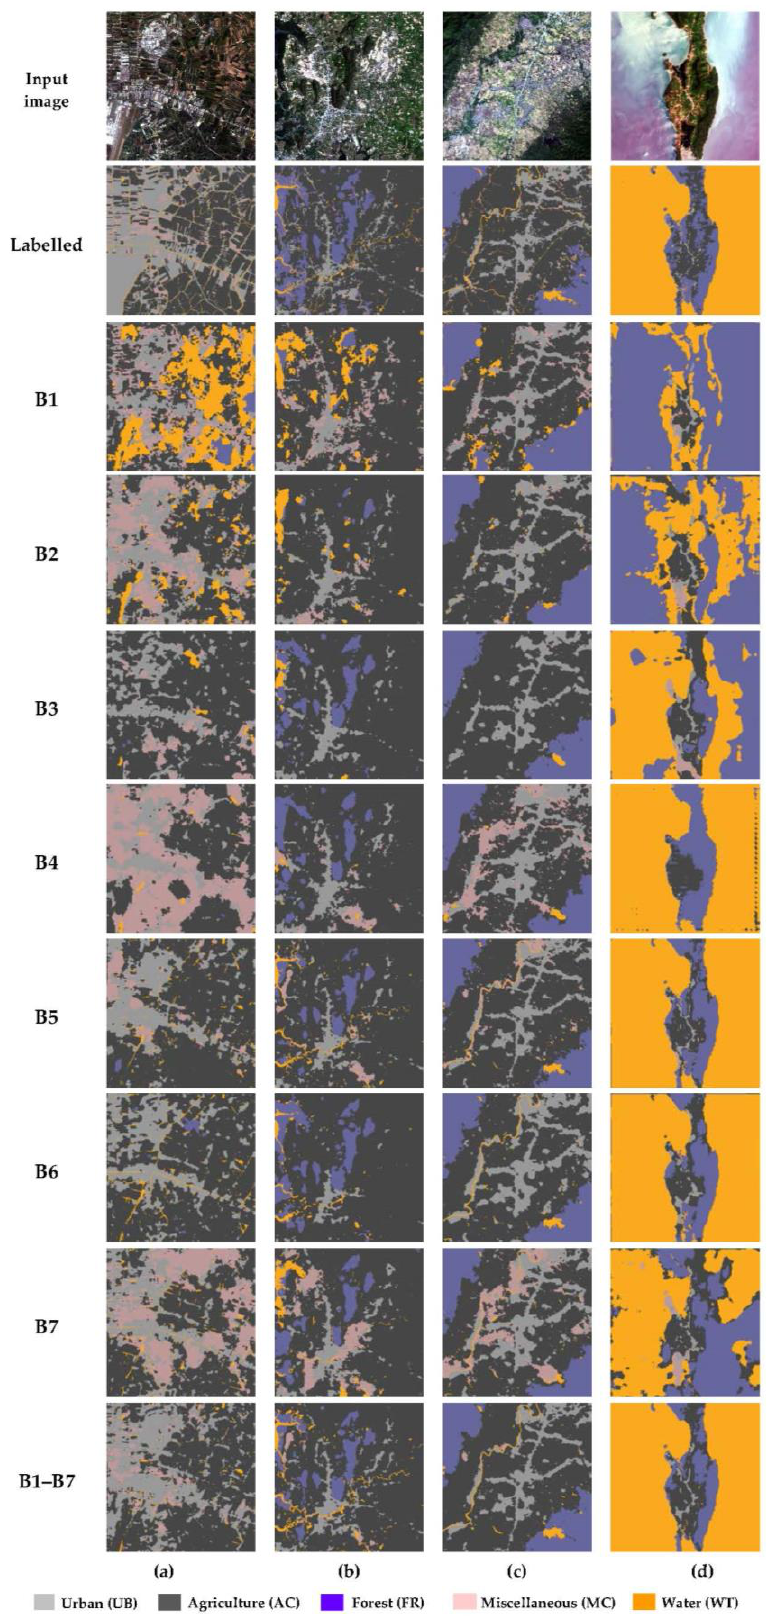
Figure 8. The segmentation results of spectral bands on the land use dataset. ( a ) urban and agriculture area; ( b ) urban, agriculture, and forest areas in countryside; ( c ) urban and agriculture areas in valley; ( d ) urban, agriculture and forest areas on island.